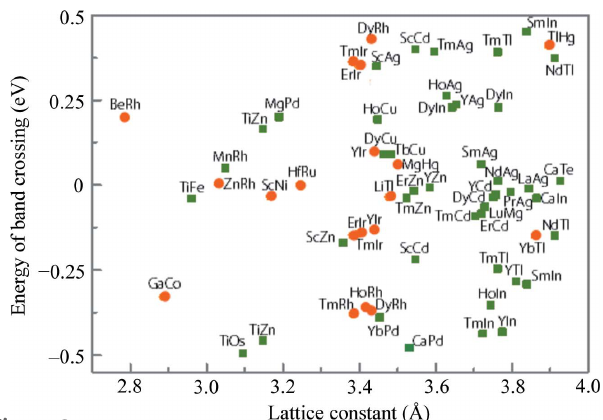
Figure 3 Identified TMs with triple-nodal-point (orange circles) and nodal-line (green squares) in CsCl-type materials. The longitudinal ordinate is the energy position of band crossing for the triple nodal point and nodal line. The horizontal ordinate is the equilibrium lattice constant.